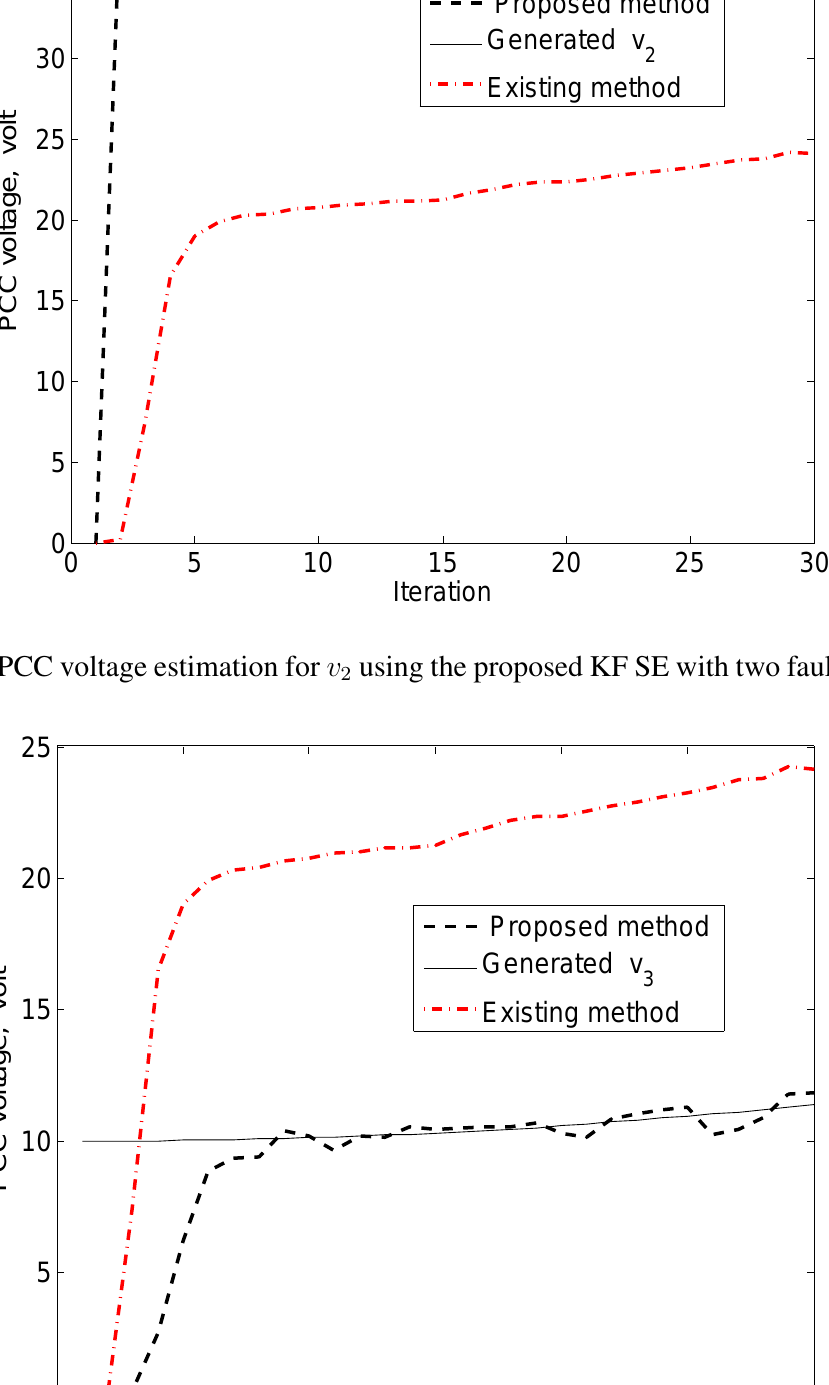
using the proposed KF SE with two faulty 3